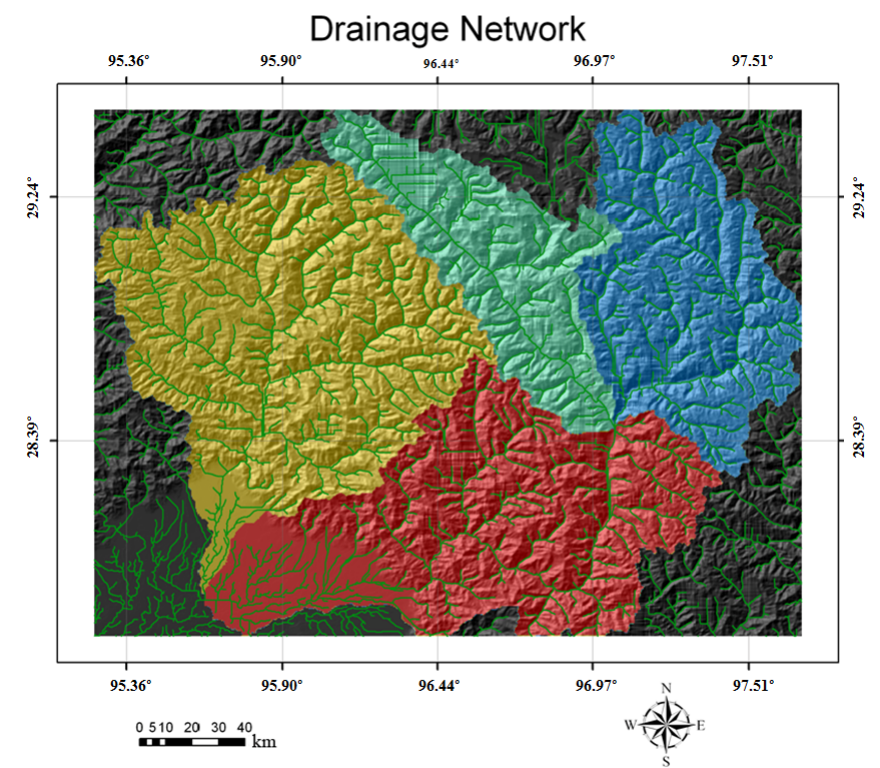
Figure 3. The drainage system in the Puqu Fault Region. Different colors indicate diverse subbasins